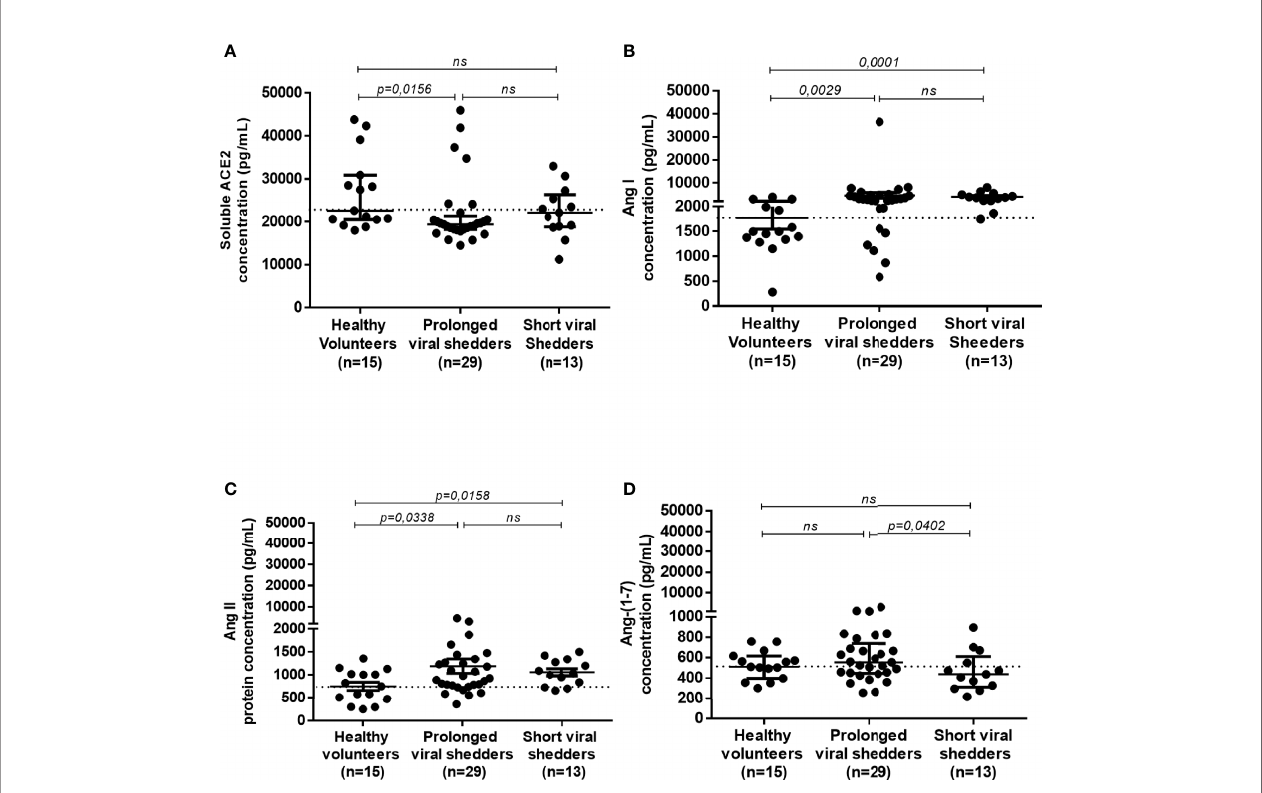
FIGURE 3 | ELISA quanti fi cation of the sACE2 protein, and angiotensin metabolites Ang I, Ang II, and Ang-(1-7), in different groups of COVID-19 patients and healthy volunteers. Quanti fi cation of sACE2 (A) , Ang I (B) , Ang II (C) , and Ang-(1-7) (D) in the plasma of prolonged viral shedders (n=29) and short viral shedders (n=13) compared to the healthy volunteers control group (n=15), using antigen-speci fi c ELISA. The results are presented as median with con fi dence interval. The Mann – Whitney test was used for the statistical analysis. ns, not signi fi